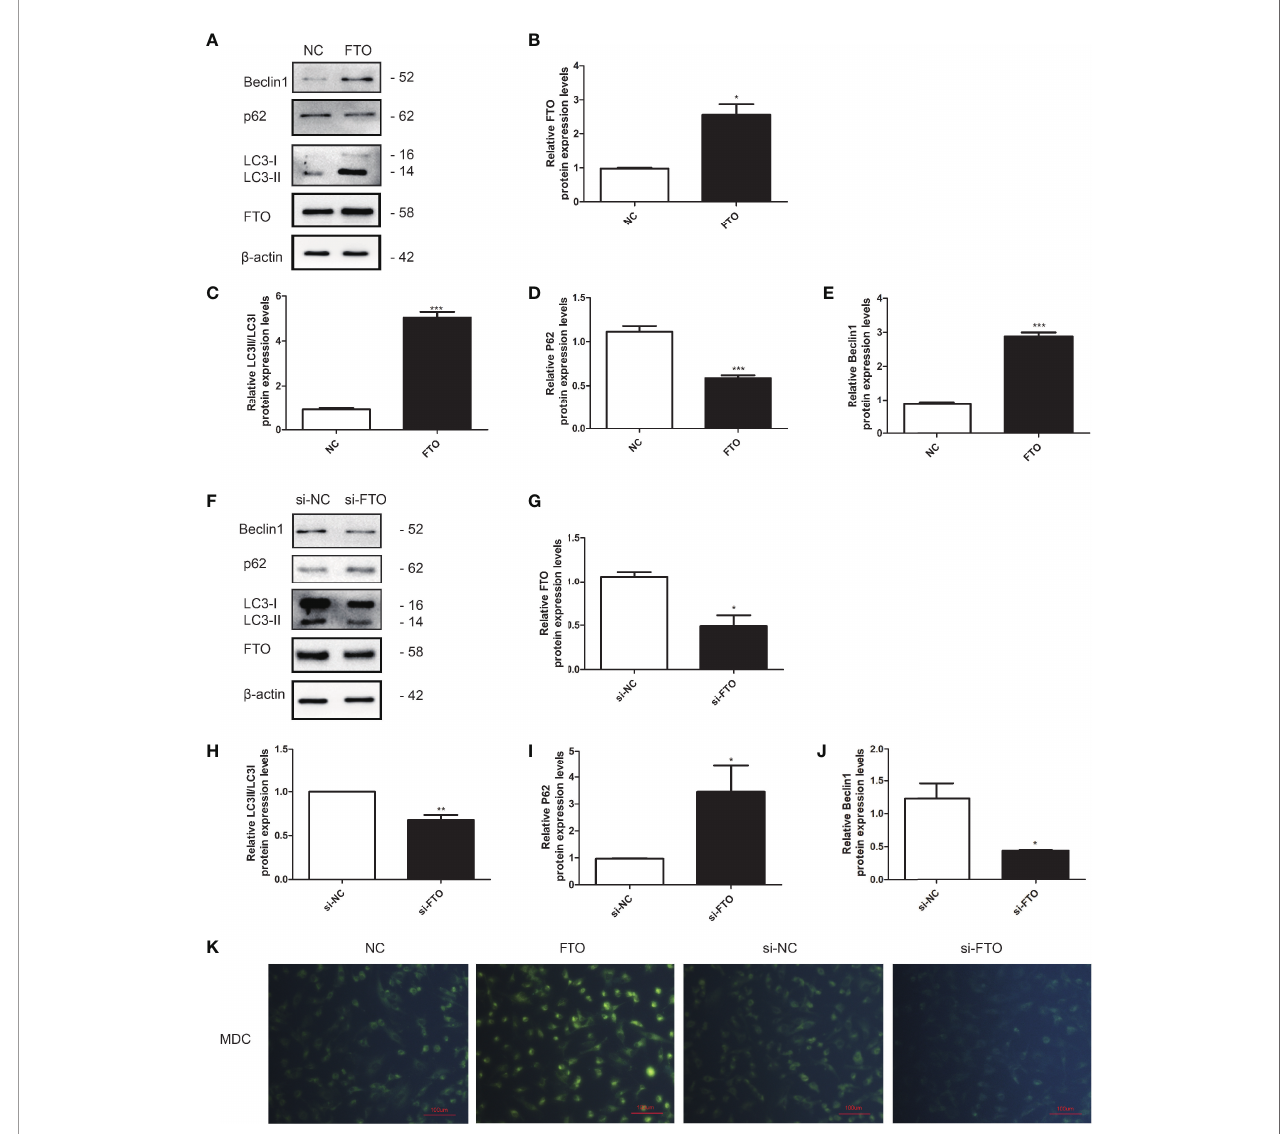
FIGURE 7 | FTO promoted autophagy in KGN cells. (A, B) The transfection ef fi ciency of FTO was measured by Western blot. (C – E) Quantitative comparison of the different expression levels of LC3, Beclin1, and p62. Student ’ s t-test. The results were shown as mean ± SEM from three independent experiments ( a = 0.05, * P < 0.05, *** P < 0.001). (F, G) The transfection ef fi ciency of si-FTO was measured by Western blot. (H – J) Quantitative comparison of the different expression levels of LC3, Beclin1, and p62. Student ’ s t-test. The results were shown as mean ± SEM from three independent experiments ( a = 0.05, * P < 0.05, ** P < 0.01). (K) Representative images of KGN cells were treated with NC, FTO, si-NC, and si-FTO, and then cells were stained with MDC (scale bar: 100 m